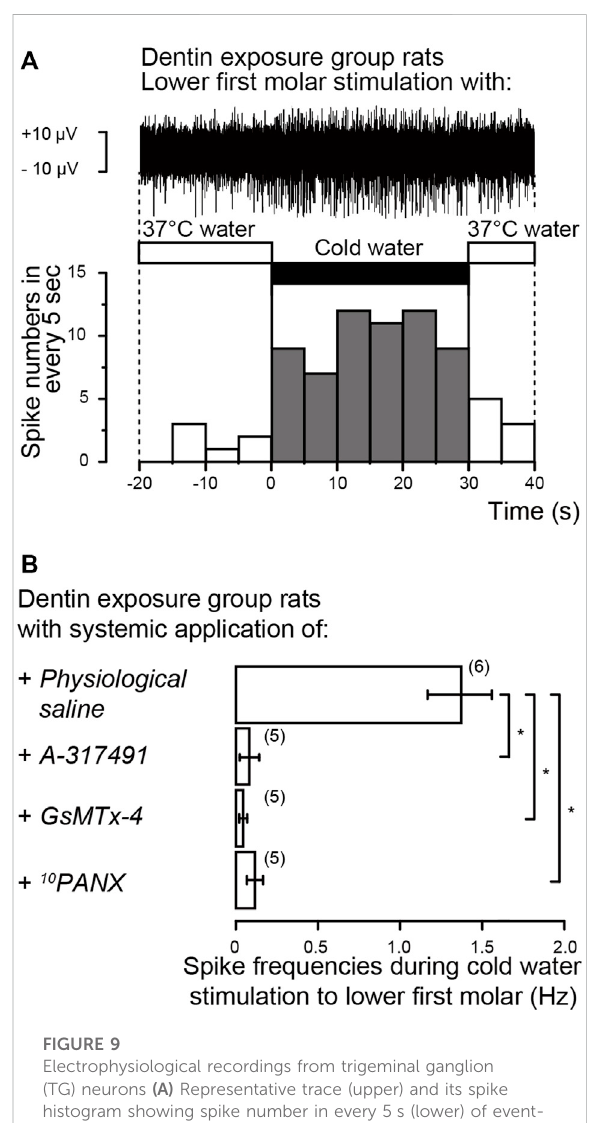
FIGURE 9 Electrophysiological recordings from trigeminal ganglion (TG) neurons (A) Representative trace (upper) and its spike histogram showing spike number in every 5 s (lower) of event- related neuronal activities from the whole TG neurons following cold water (middle black box) or warm water (middle open boxes) stimulation to exposed dentin surface of lower fi rst molars in rat injected by physiological saline intraperitoneally. The stimulated dentin was adapted to warm (37.0 ° C) distilled water, and the cold (4.0 – 7.0 ° C) stimulus was applied for ~30 s (B) Averaged spike frequencies in response to cold water stimuli to exposed dentin surface of lower fi rst molars in the rat following intraperitoneal injection of physiological saline (upper; n = 6), A- 317491 (second upper; n = 5), GsMTx-4 (second lower; n = 5) or 10 PANX (lower; n = 5). Each bar represents the mean ± SD of the number of experiments. Asterisks denote signi fi cant differences between columns (shown by solid lines): * p <